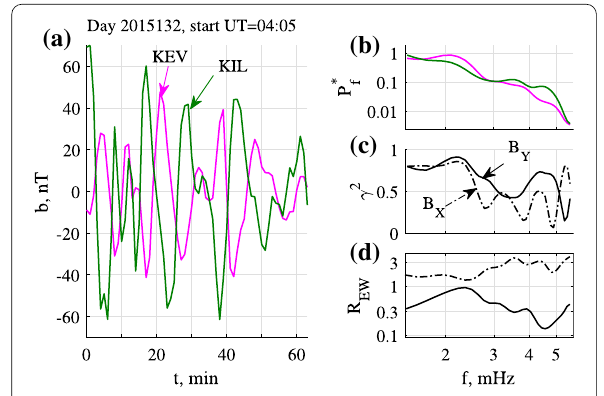
Fig. 6 Parameters of the event 2 pulsation in the E–W direction: a B Y waveforms at KEV (magenta) and KIL (green); b normalized PSD spectra; c E–W spectral coherence for B Y (solid) and B X (dashed); d E–W PSD ratio for B Y (solid) and B X